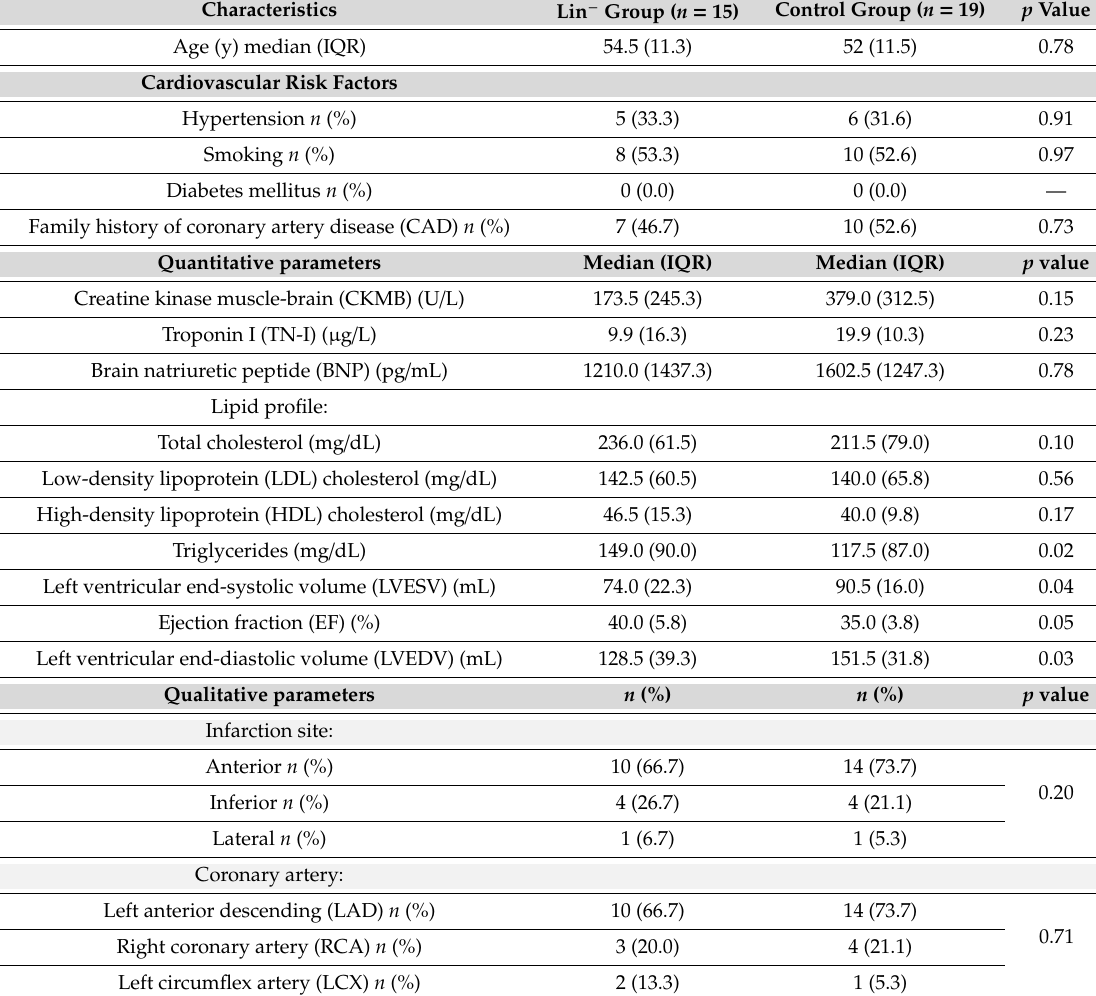
Table 1. Clinical characteristics of the study